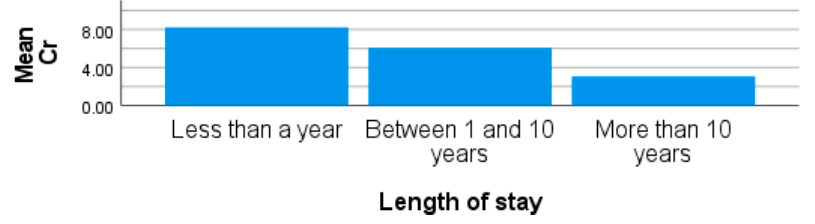
Figure 2. Showing blood Cr by length of stay in obese females living around site 3. The concentration of Co from participants from site 3 was higher than the other two sites, with a mean and standard deviation of 2.40 ± 8.92 µg/L and with values ranging from 0.09 µg/L to 50.88 µg/L. From site 1, Co concentrations showed a range of 0.20–18.84 µg/L and a mean of 2.19 ± 4.43 µg/L. Although the mean Co concentration from site 2 was 1.08 ± 1.34 µg/L, it was recorded as the lowest when compared to sites 1 and 3. However, the mean concentrations for all the sites were higher than the recommended limit for human exposure as set by the WHO. No significant difference was observed in the blood concentrations of Co in participants from the sites in this study ( p > 0.05). The consumption of beer may be a source of high levels of Co recorded from the blood of participants as they were observed to be drinking during sampling from both sites 1 and 2. Although participants from site 3 were not observed to be drinking beer during the sampling visits, they do consume other alcoholic beverages. Studies also showed that individuals who consume high volumes of alcohol, especially beer with added cobalt chloride (CoCl 2 ) or cobalt sulphate (CoSO 4 ), a foam stabilizer, may suffer from cardiomyopathy [60–62]. Reports show that Mn and Co concentrations in beer samples ranged from 25.29 to 228.60 µg/L and 0.16 to 0.56 µg/L, respectively [63,64]. Therefore, the consumption of alcoholic